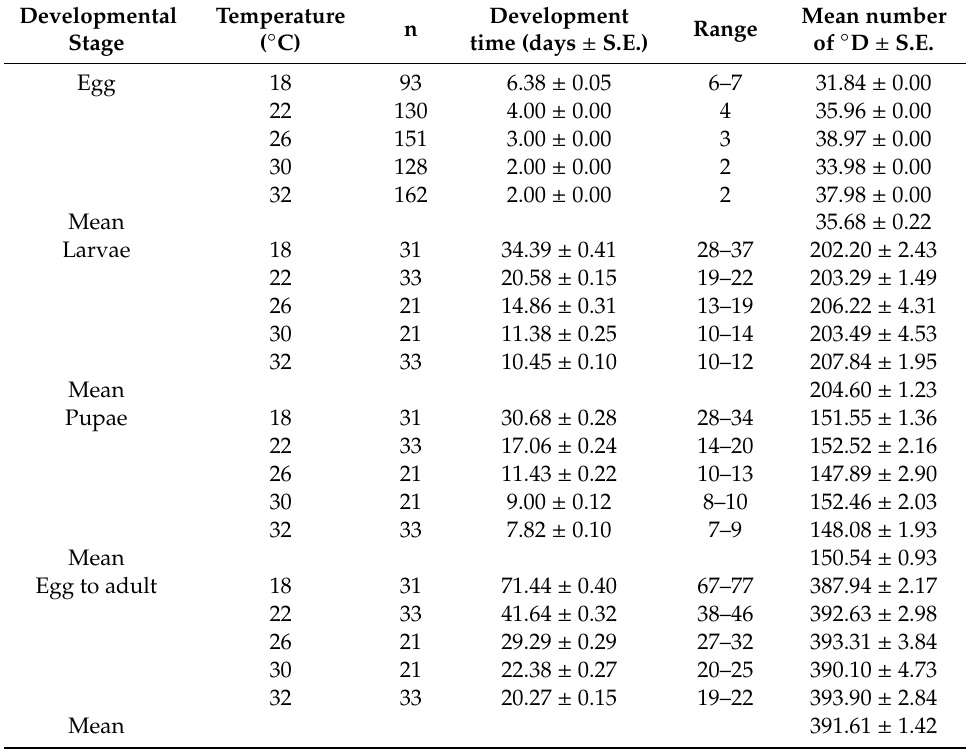
Table 3. The mean development time in days and degree-days ( ◦ D) for Spodoptera frugiperda at constant temperatures. Degree-days were calculated using the lower threshold temperature for development for each developmental stage (eggs = 13.01 ◦ C, larvae = 12.12 ◦ C, pupae = 13.06 ◦ C and egg to adult = 12.57 ◦